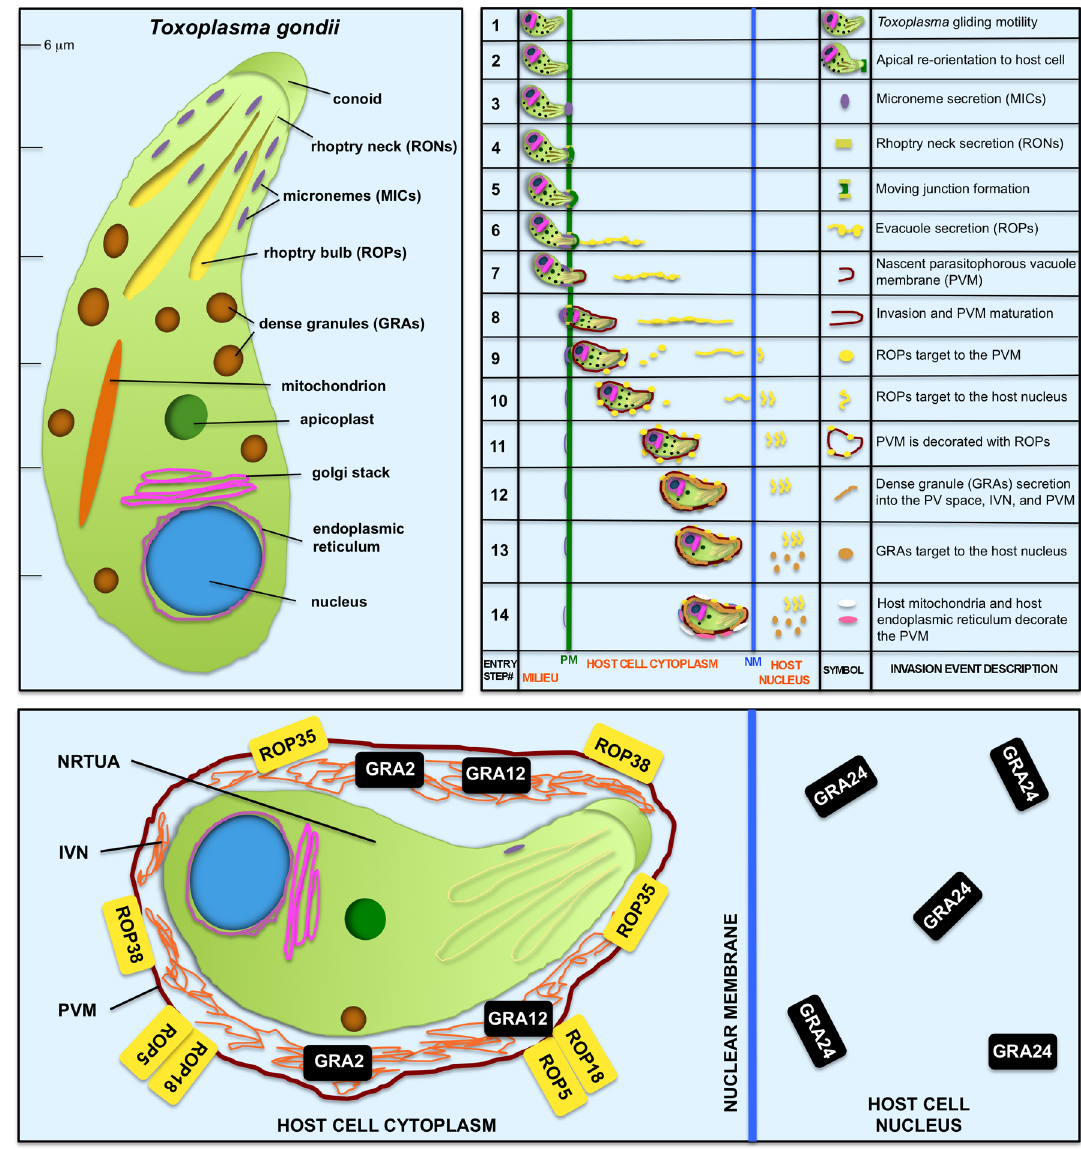
Fig 2. Toxoplasma is a bottle-shaped eukaryotic microbe that uses specialized secretoryorganelles to invade the host cell, to establish a parasitophorous vacuole, and to manipulate host signaling and transcriptional pathways. Top-left panel: Toxoplasma secretory organelles.Top-rightpanel: 14 events that occur duringinvasionof the host cell to establishthe parasitophorous vacuolehabitat as well as manipulation of the host cell (adaptedfrom reference [16]). The displayedorder of these invasionsteps should be interpretedcautiouslyat this time since the elucidationof the precise order of some of these steps and the mechanisms regulatingglidingmotility, invasion,and secretionevents are major topics of ongoingresearchinto the biologyof Toxoplasma [16, 29, 32]. Bottom panel: An expandedview of an NRTUA-invadedcell shows the host cell localization of Toxoplasma secreted effectors necessary to trigger an antitumor response. See the main text for explanations. Abbreviations: GRA, protein secreted from the densegranules;IVN, intravacuolar network; MIC, micronemeadhesinor other microneme secreted protein; NM, nuclear membraneof the host cell; NRTUA, nonreplicating Toxoplasma uracilauxotroph; PM, plasma membraneof the host cell; PVM, parasitophorousvacuolemembrane; PV space, parasitophorous vacuole space; RON, rhoptry neck secreted protein;ROP, rhoptry bulb secreted protein.